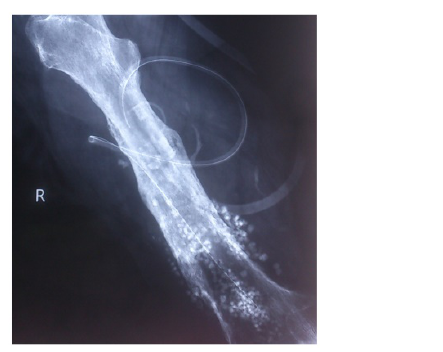
Figure 2. Post operative radiograph with SPHCS